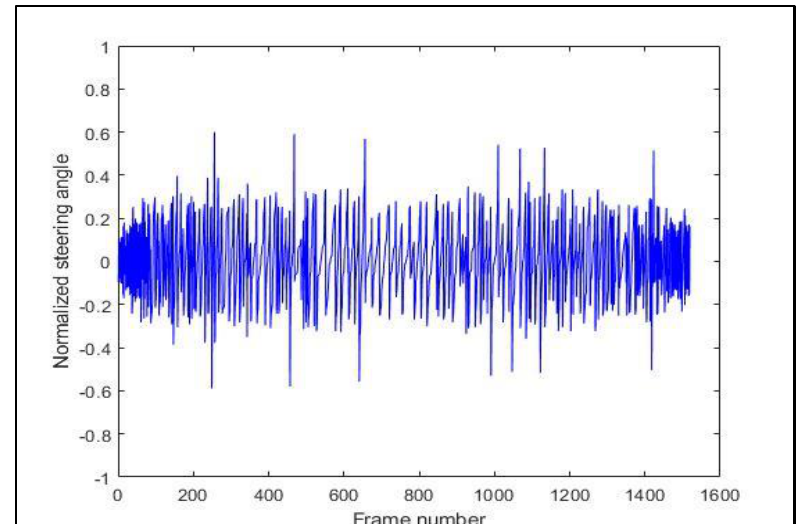
Fig. 7. Dataset of Normalized Steering